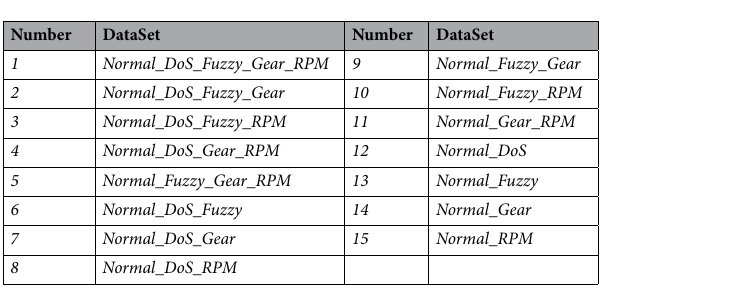
Figure 8. The CNN model structure used in this paper.